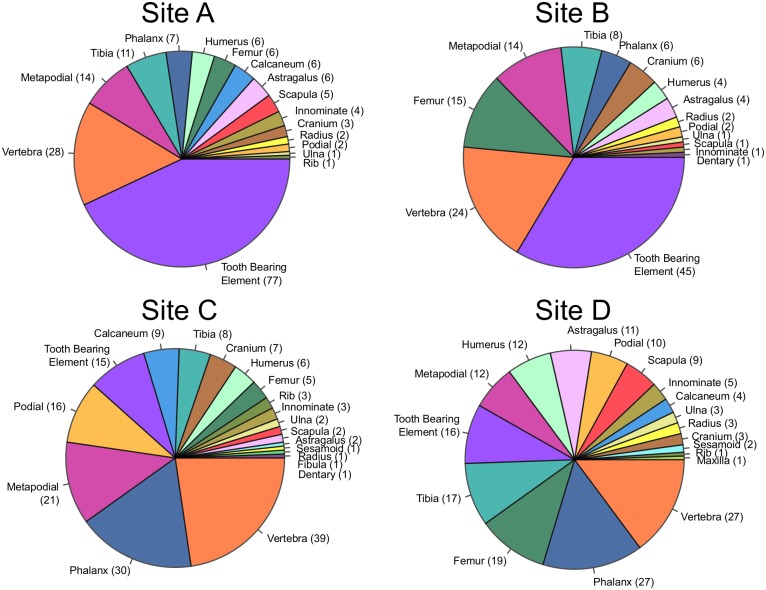
Distribution of Elements by Facies.The distribution of elements at the sandstone and siltstone sites is notably different in the proportion of tooth bearing elements; sandstone sites appear to be dominated by this category, while siltstone sites are not.